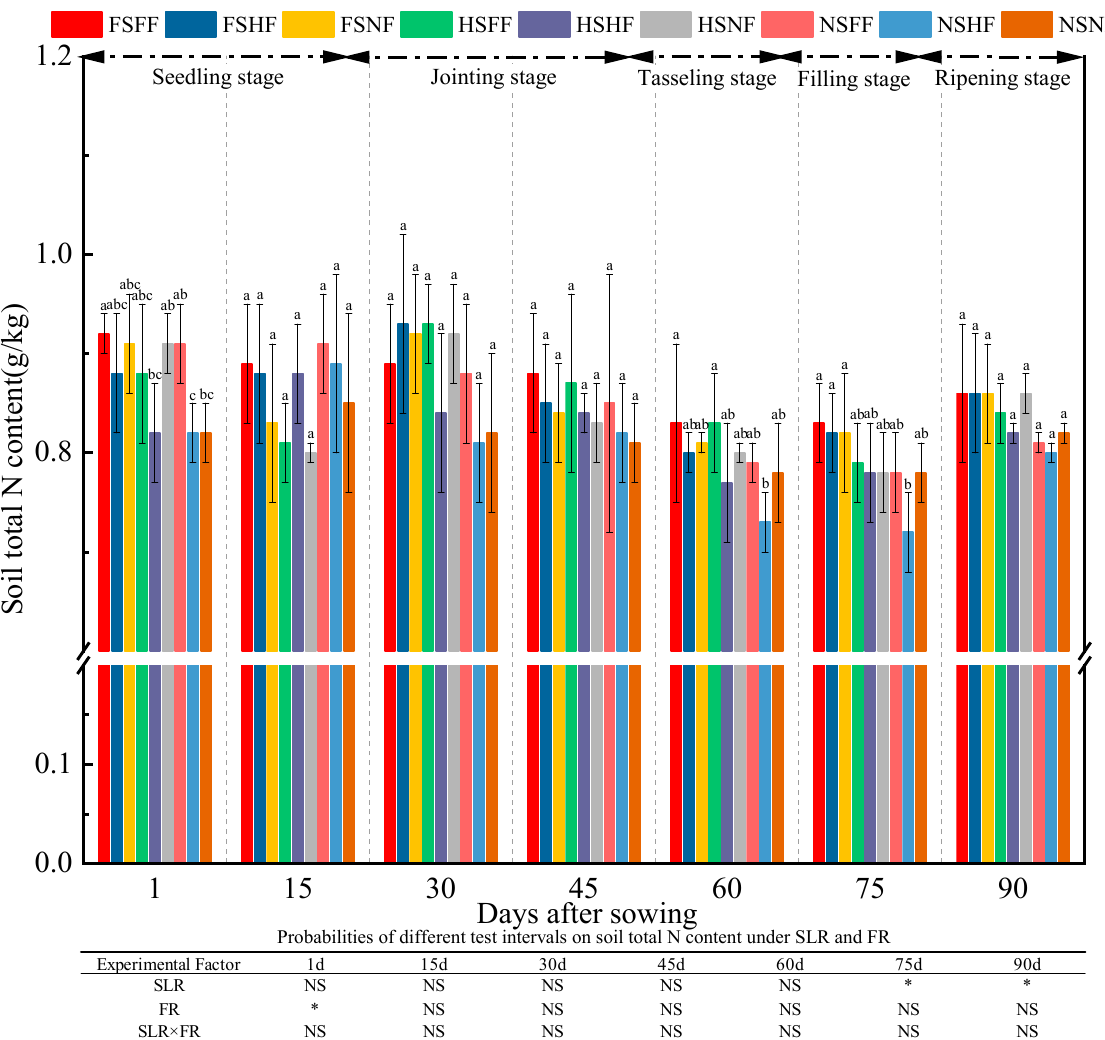
Figure 7. Effects of SLR and FR on soil TN content. Note: Bars represent means ± standard deviation ( n = 3) with different letters indicating significant differences based on LSD ( p ≤ 0.05). SLR, sugarcane leaf return; FR, fertilizer reduction.